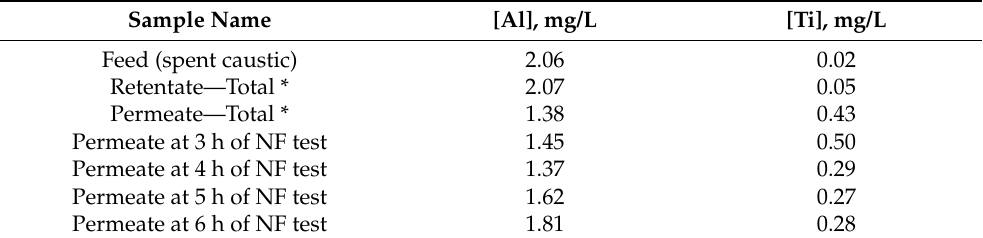
Table 4. ICP analysis of feed, retentate and permeate samples after/during the NF test with the 200 Da